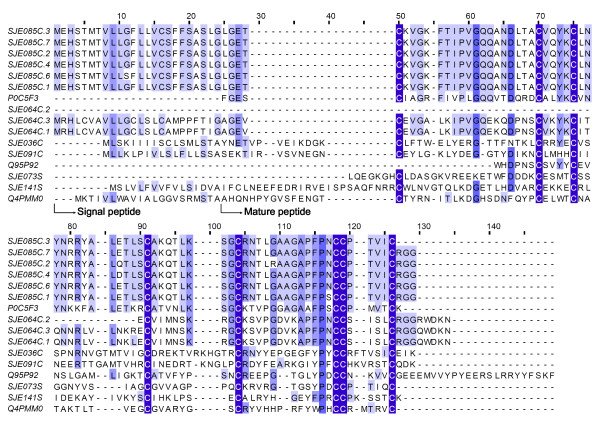
Sequence alignment of La1 like peptides. SJEs are clusters from this work. The others are P0C5F3 (Venom peptide La1, Liocheles australasiae), Q4PMM0 (Putative secreted salivary protein, Ixodes scapularis), and Q95P92(TXLP1, Mesobuthus martensii).